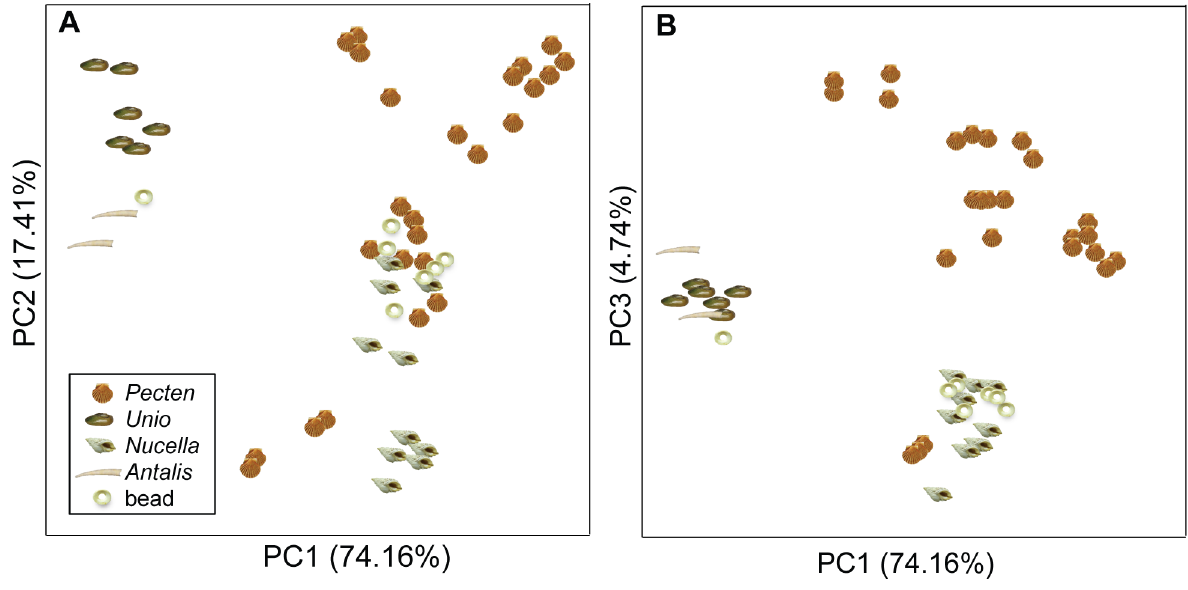
Figure 7. PCA scores plots showing examples closest to the beads. Scores plots from principal components analysis showing only examples from genera with scores closest to the beads. Bead 3870 can be seen, clustered with Unio and Antalis examples on the left of the plots. Although Pecten examples overlap with Nucella and the other beads in the scores plot for the first two principal components (a), separation can be seen along the third component (b).